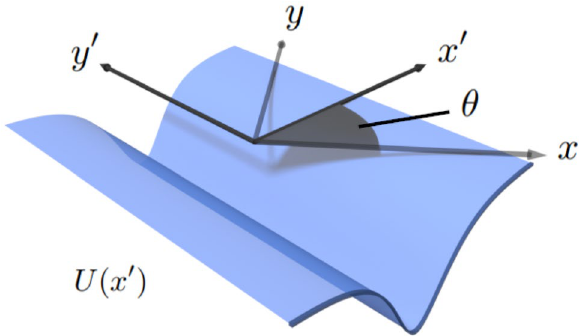
Figure 1. A schematic diagram of an electrostatic potential, U ( x ′ ) , created by an applied top-gate voltage in a tilted 2D Dirac material. The waveguide is orientated at an angle of θ , relative to the x -axis of the crystal. The potential is invariant along the y ′ -axis, and varies in strength along the x ′ -axis. The x ′ the solid black arrows, whereas the crystallographic axes x